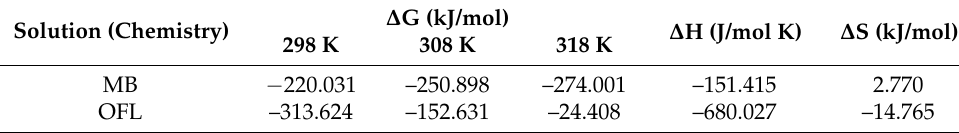
Table 2. Thermodynamic parameters of adsorption of MB and OFL by